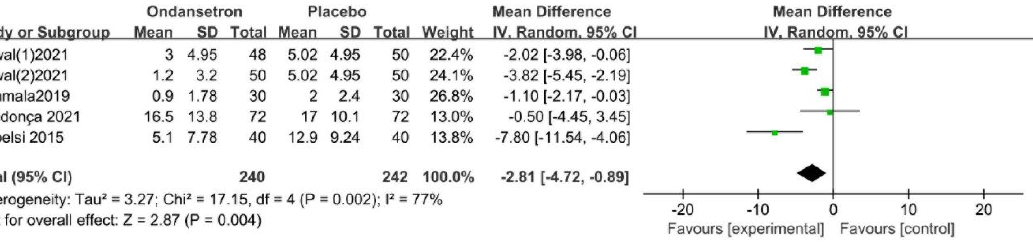
Figure 6. Forest plot of the pooled analysis showing the dose of administered ephedrine.[12, 13, 30, 48]